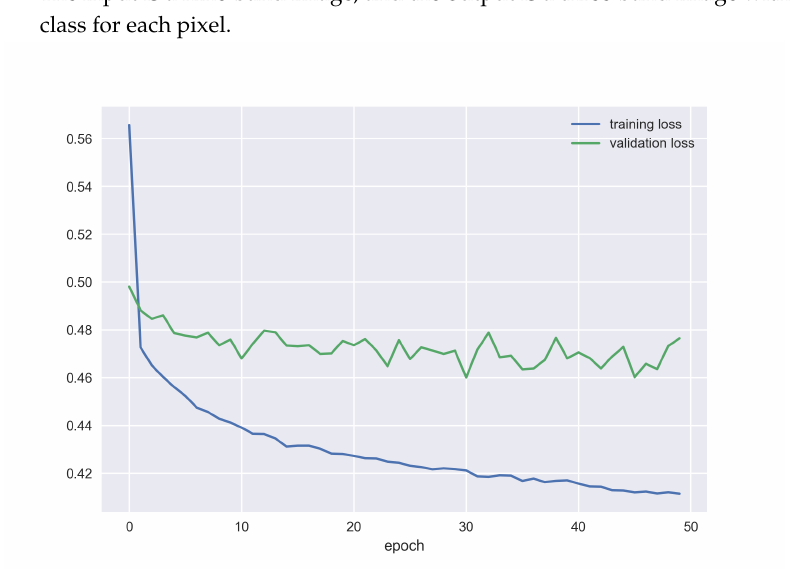
Figure 4. U-Net model diagram [12]. The arrows with different colors indicate different operations. The input is a nine-band image, and the output is a three-band image with the probability of each class for each pixel.